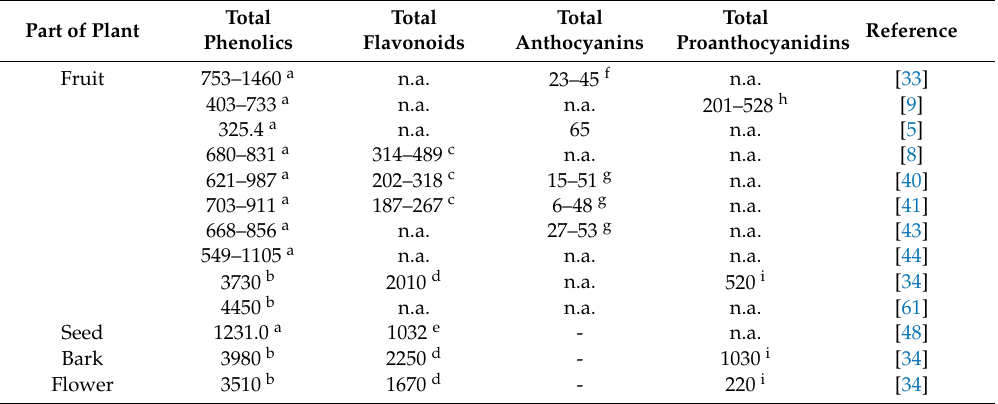
Table2. Concentrationsoftotalphenolics, flavonoids, anthocyanins, andproanthocyanidinsdetermined by spectrophotometric methods in di ff erent morphological parts of Viburnum